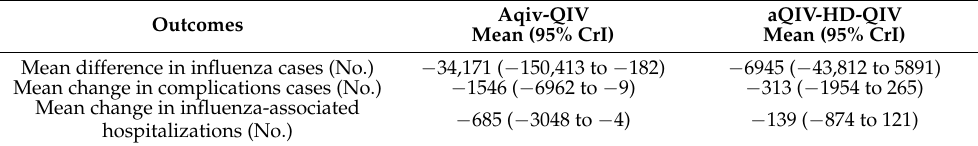
Table 4. Probabilistic sensitivity analysis results based on 1000 simulation runs. Outcomes Aqiv-QIV Mean (95% CrI) aQIV-HD-QIV Mean (95%